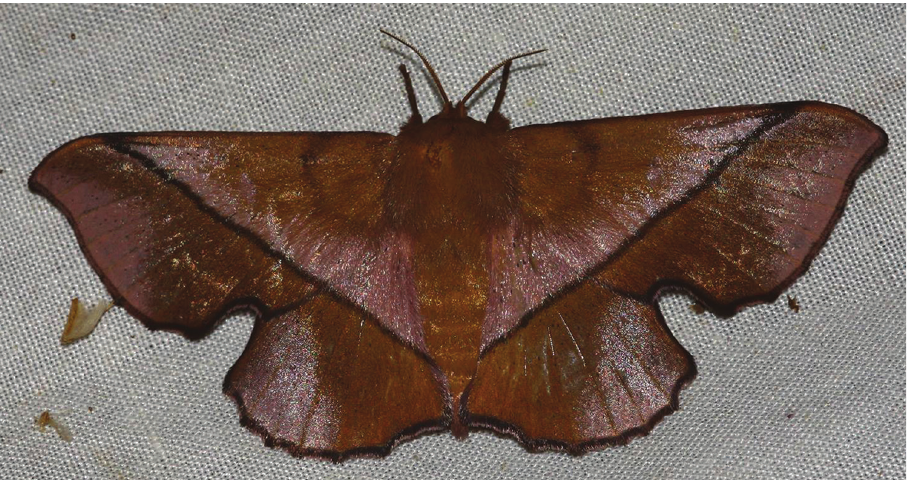
Figure 6. Reinmara enthona ♀ , Suriname, Brokopondo, Brownsberg NP, 490 m (Photograph courtesy of A.J. Hielkema, used with